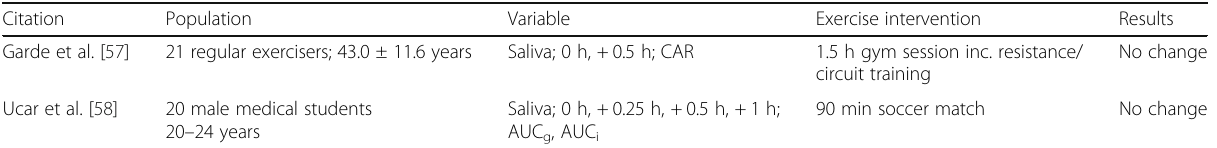
Table 3 CAR as a response to a single exercise bout ( n = 2)